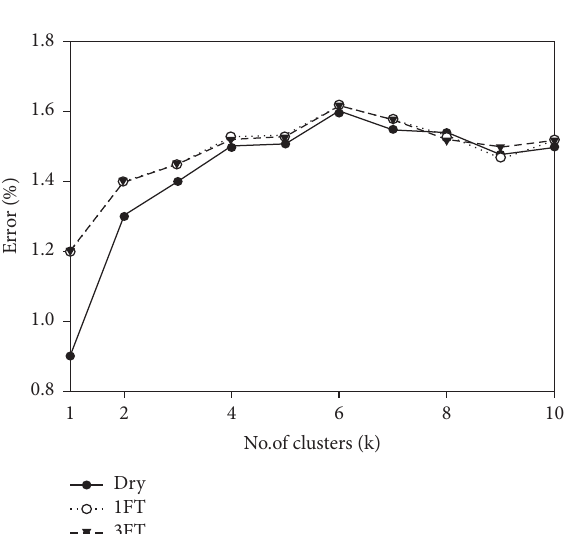
Figure 16: Accuracy of PKIP using